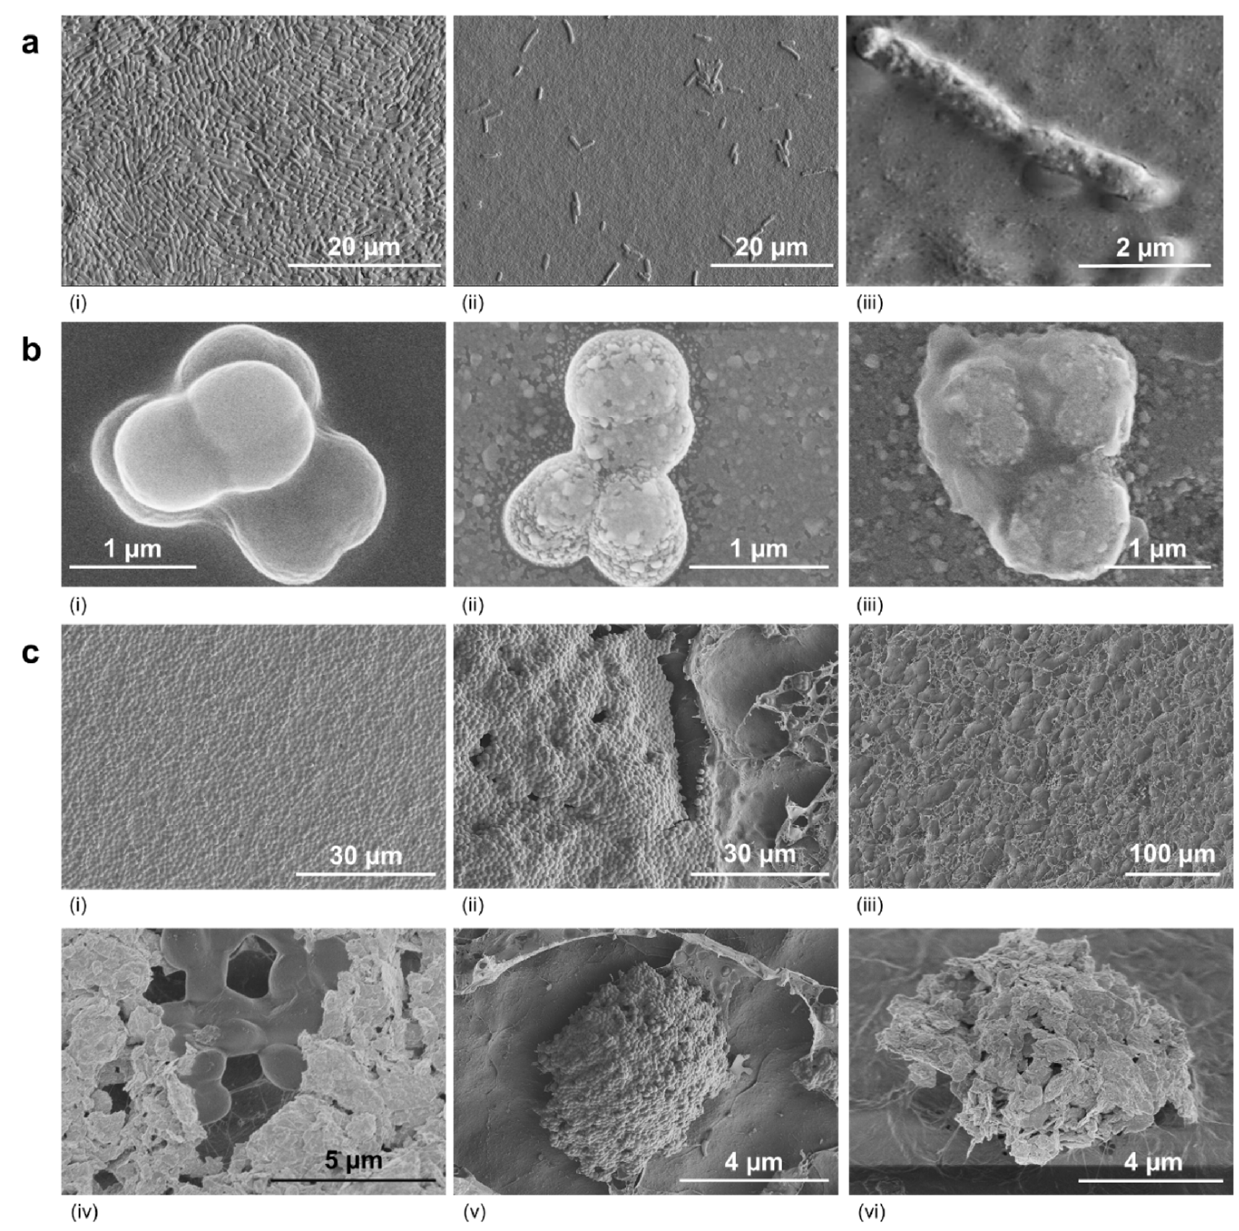
Figure 6. Scanning electron micrographs of bacteria exposed to selected volatile organic compounds. ( a ) E. coli in the ( i ) absence and ( ii , iii ) presence of isovaleric acid. ( b ) M. luteus in the ( i ) absence and ( ii , iii ) presence of isovaleric acid. Cell surface blebbing is visible, with an altered shape and evidence of autolysis. ( c ) Cryo-SEM of M. luteus in the absence ( i ) and presence of isovaleric acid: ( ii ) edge of the zone of inhibition showing healthy cells alongside lysed cells, ( iii ) zone of inhibition showing islands of intact and unhealthy cells, ( iv ) details of healthy and dying cells, ( v ) micro-colony of healthy cells in the zone of inhibition and ( vi ) micro-colony of dying cells.